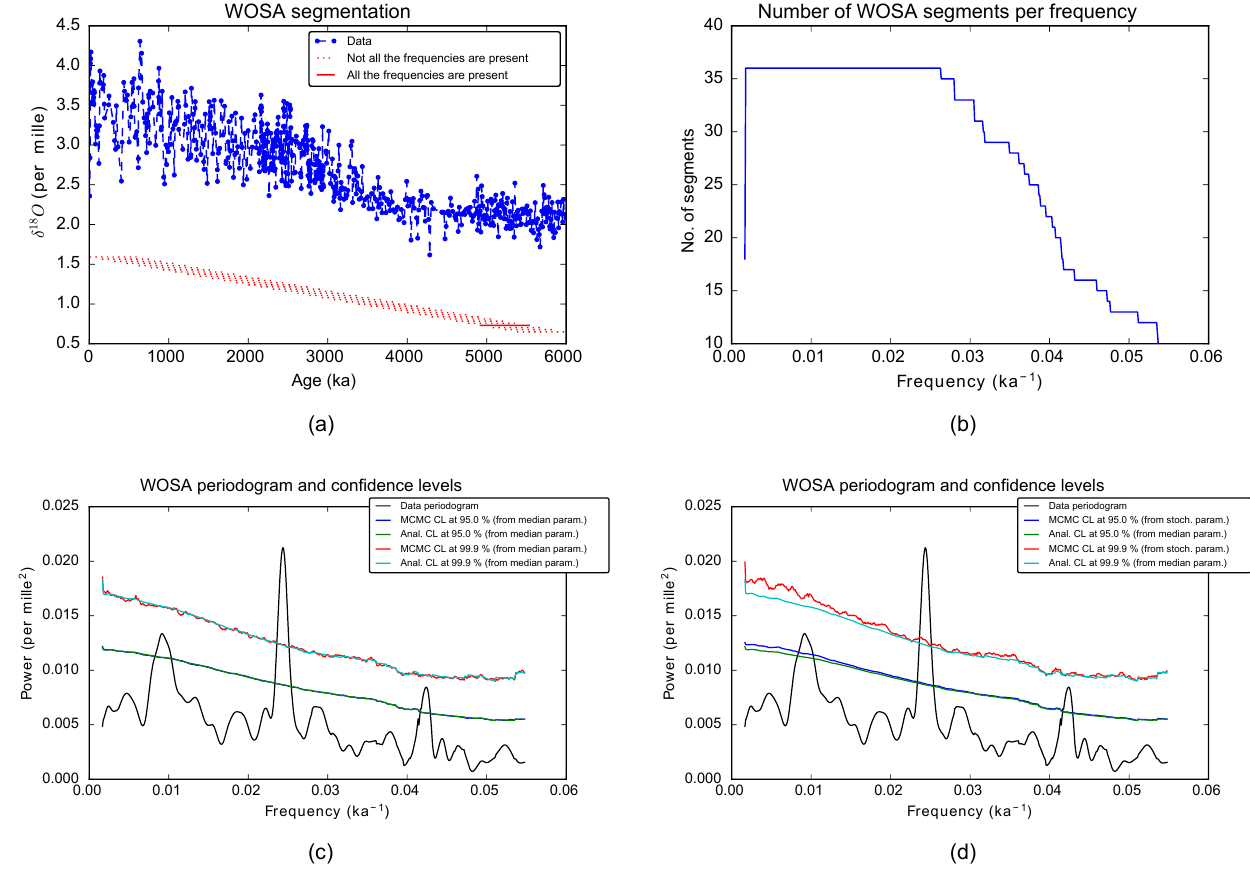
Figure 8. Frequency analysis. (a) The time series, in blue, and the WOSA segments, in red. (b) Number of WOSA segments per frequency. (c, d) Weighted WOSA periodogram and the confidence levels (CL) at 95 and 99.9%. Analytical CL (Anal. CL) are computed with the median parameters of the red noise process. In panel (c) , the MCMC CL are computed from the MCMC red noise time series, all generated with the median red noise parameters. In panel (d) , the MCMC CL are computed from the MCMC red noise time series, generated with stochastic parameters, that are taken from the joint posterior distribution of the parameters of the red noise